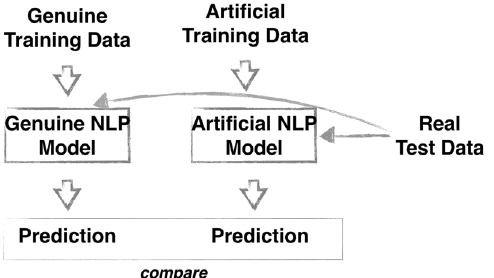
Fig. 2 Overview of the extrinsic evaluation procedure. An NLP model is built on 1) genuine data and 2) arti fi cial data. Both models are tested on real (genuine) test data. Comparing these results gives an indication of the usefulness of using arti fi cial data for NLP model development.